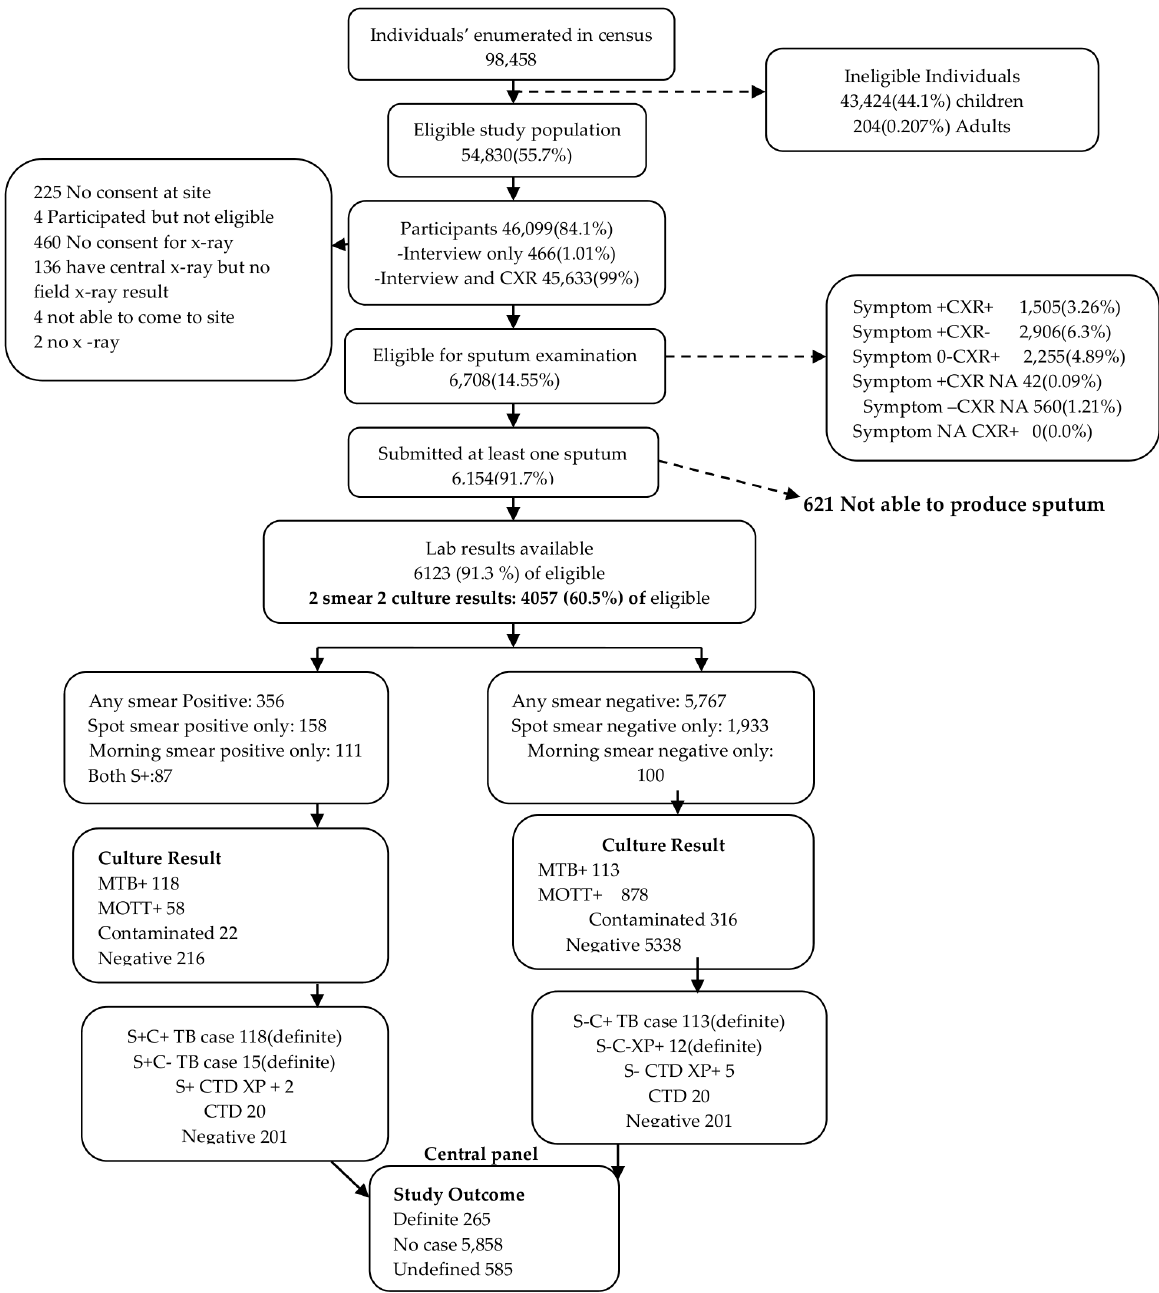
Fig 1. Survey data flow. CXR, Chest X-rays read; Symptom+ CXR+, Symptoms present and Chest X-ray abnormality detected; Symptom+ CXR-, Symptoms present and Chest X-ray abnormality not detected; Symptom- CXR+, Symptoms absent and Chest X-ray abnormality detected; Symptom+ CXR NA, Symptoms present and Chest X-ray not applicable; Symptom- CXR NA, Symptoms absent and Chest X-ray not applicable; Symptom NA CXR+, Symptoms not applicable and Chest X-ray abnormality detected; MTB+, positive for Mycobacterium Tuberculosis; MOTT+, positive for Mycobacterium Other Than Tuberculosis; C+, Culture positive; C-, Culture negative; S+, Sputum smear positive; S-, Sputum smear negative; XP+, Xpert MTB/RIF result positive for MTB; CTD,